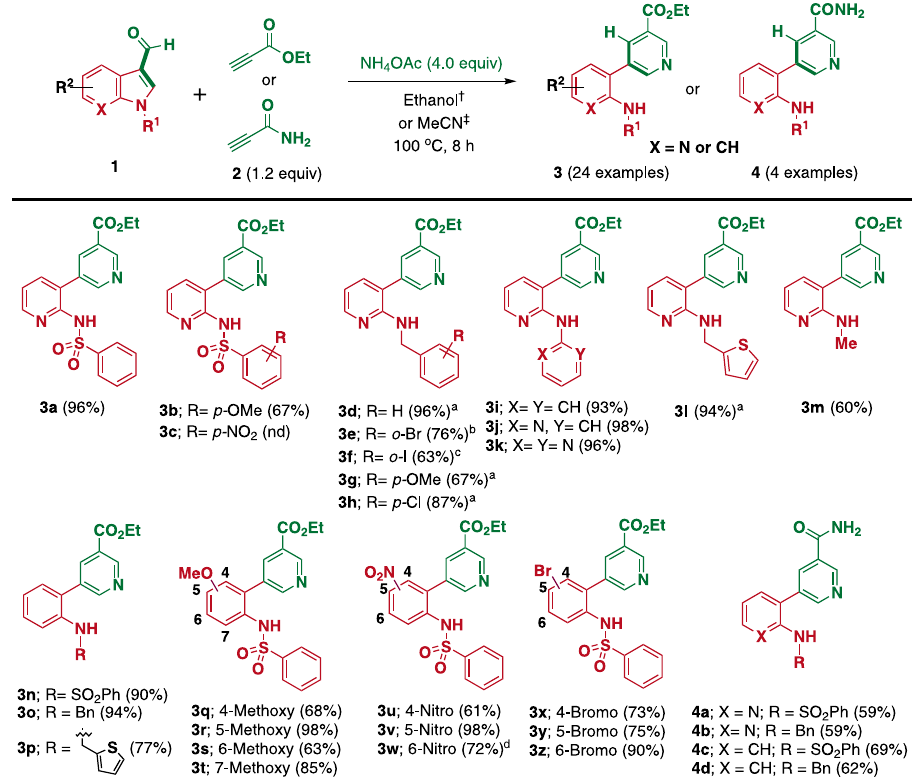
Fig. 2 Substrate scope for N- substituted (aza)indole remodeling. Reaction conditions: 1 (0.2 mmol), 2 (1.2 equiv.), NH 4 OAc (4.0 equiv.) in an appropriate solvent (2 mL) at 100 °C for 8 h. Yields of isolated products ( 3 and 4 ) are given in parenthesis. nd = not detected. † Ethanol was used as the solvent for all of the reactions except for starting materials containing sulfonyl-protected indoles. ‡ Acetonitrile was used as the solvent in the case of sulfonyl-protected indoles as substrates. a Reaction were performed at 0.5 mmol scale. b 2.0 g scale reaction with respect to 1 . c 500 mg scale reaction with respect to 1 . d Reaction time 16